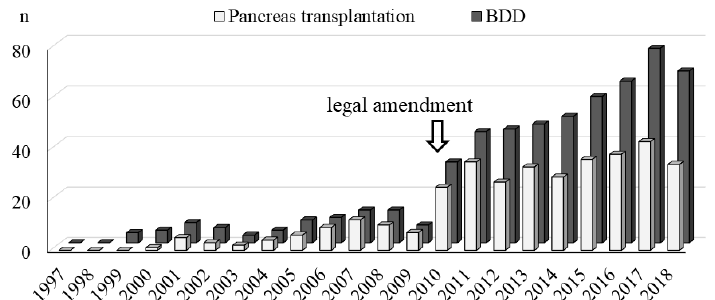
Figure 2. The annual number of brain-dead donors (BDDs) and pancreatic transplantation procedures. In Japan, the number of BDDs increased more than five-fold in 2010, after the revision of the law regarding organ donation by BDDs, and has gradually increased since then. The annual number of pancreas transplantation procedures has also increased in line with the number of BDDs.